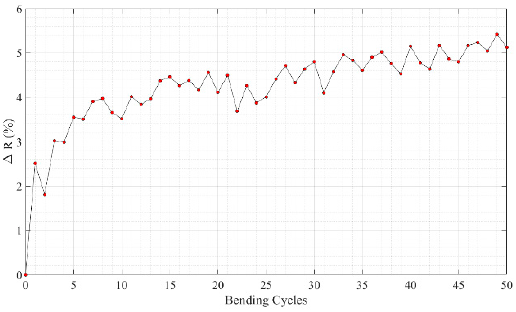
Figure 4. Percentage of sensor resistance increase during 50-cycles bending